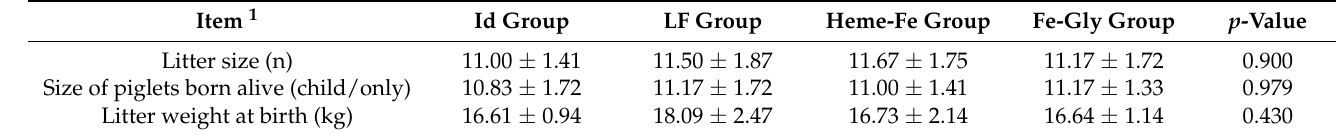
Table 3. Effects of iron additives on reproductive performance in sows.